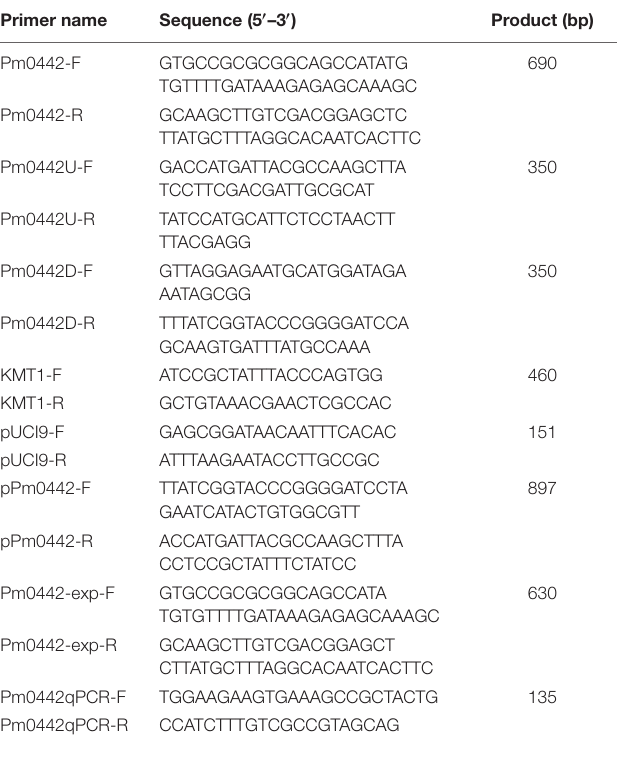
TABLE 1 | Mutant construction and protein expression primers used in this work.